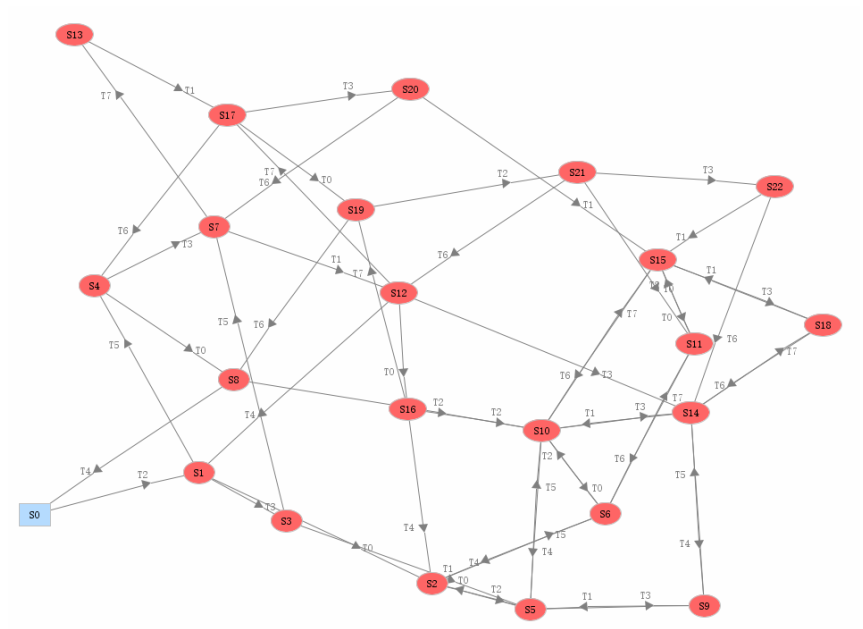
Figure 3. Reachable marking graph of Petri net of ACC.